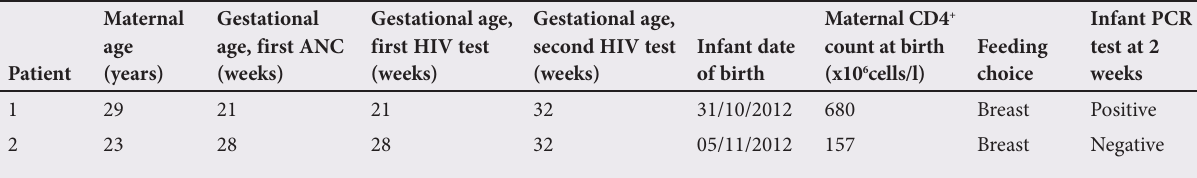
Table 1. Patient characteristics